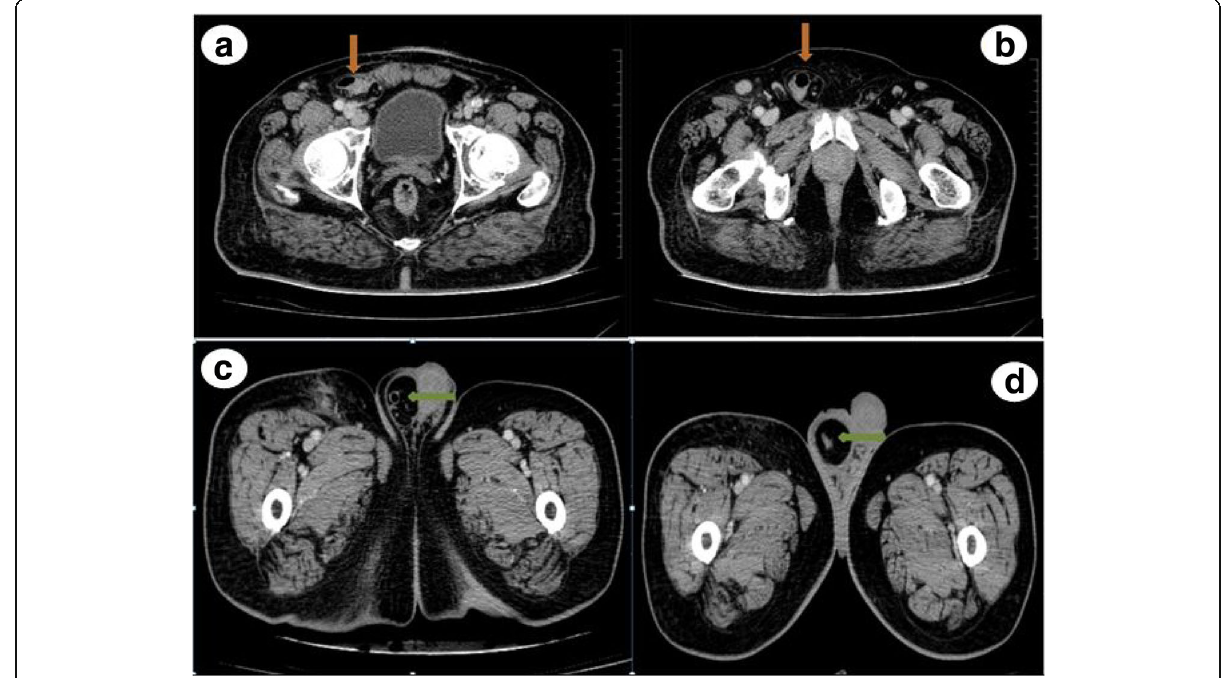
Fig. 3 CT abdomen axial section venous phase ( a , b ) at the level of the pelvis shows cecal tip (arrow mark) seen within the right inguinal canal. Few section below that ( c , d ) shows the presence of normal appendix (arrow mark) with intraluminal air and normal peri-appendiceal fat